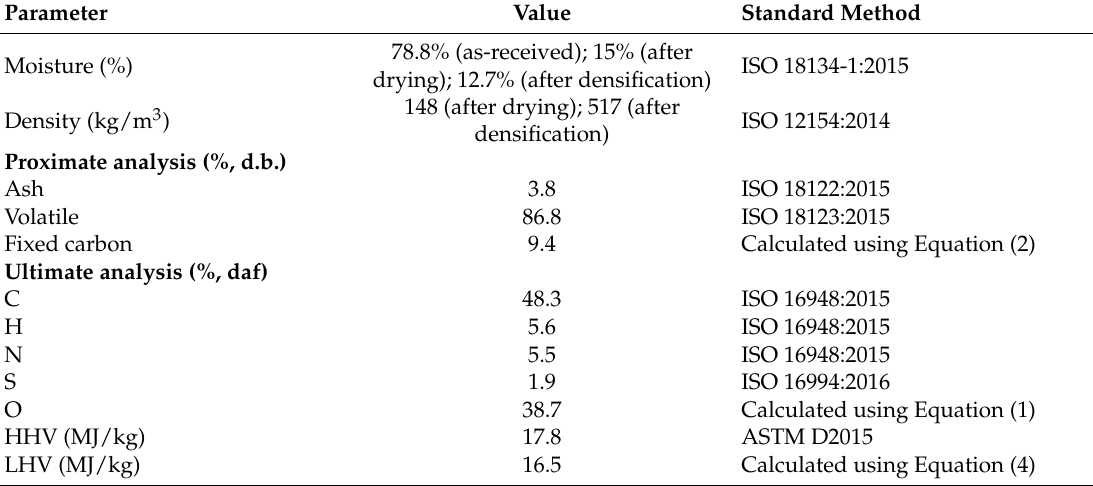
Table 1. Characterization of the brewers’ spent grains (BSG) and the standard methods used. Parameter Value Standard Method 78.8% (as-received); 15%